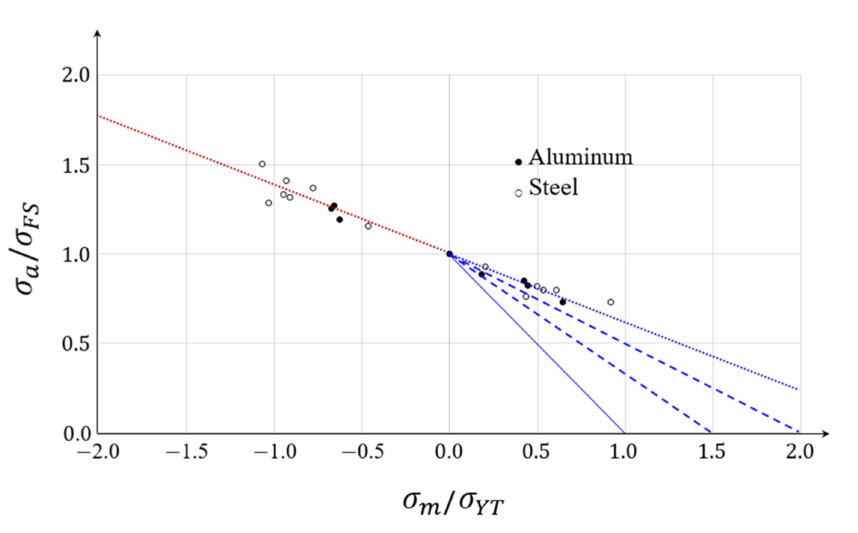
Figure 10. Effects of compressive and tensile mean stresses [6,34]. ( • ) Aluminum alloys (